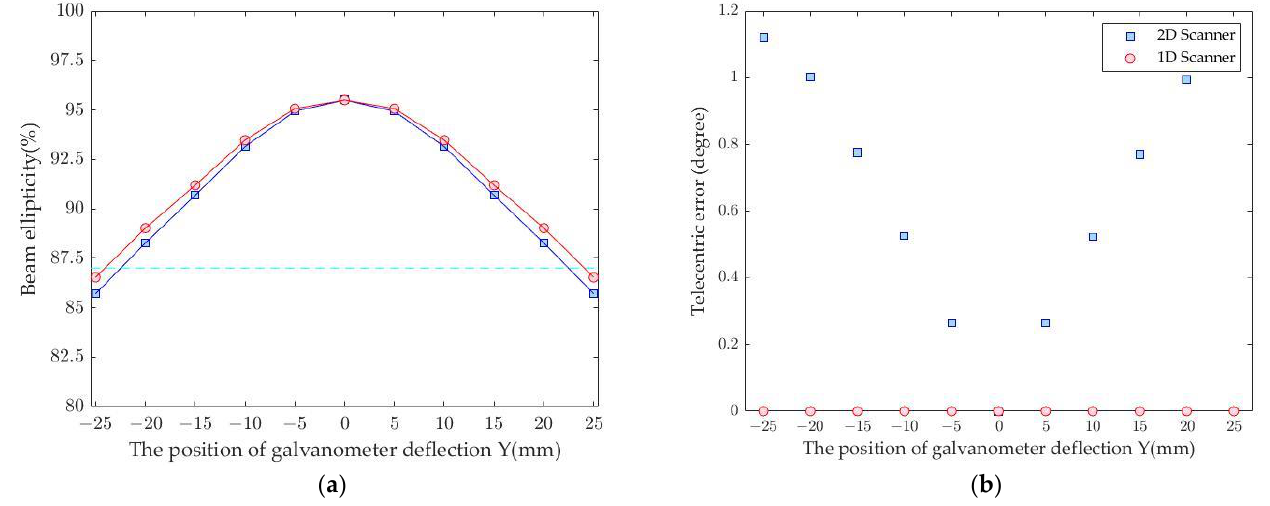
Figure 8. ( a ) Simulation results comparing the roundness of ablations of the 1D scanning system using two galvanometers in the red circle and the 2D scanning system in the blue square, in which the cyan line shows the roundness of ablations in ISO 11145:2018. ( b ) The compensation of telecentricity in the 1D scanning system using two galvanometers compared to the conventional 2D scanner.